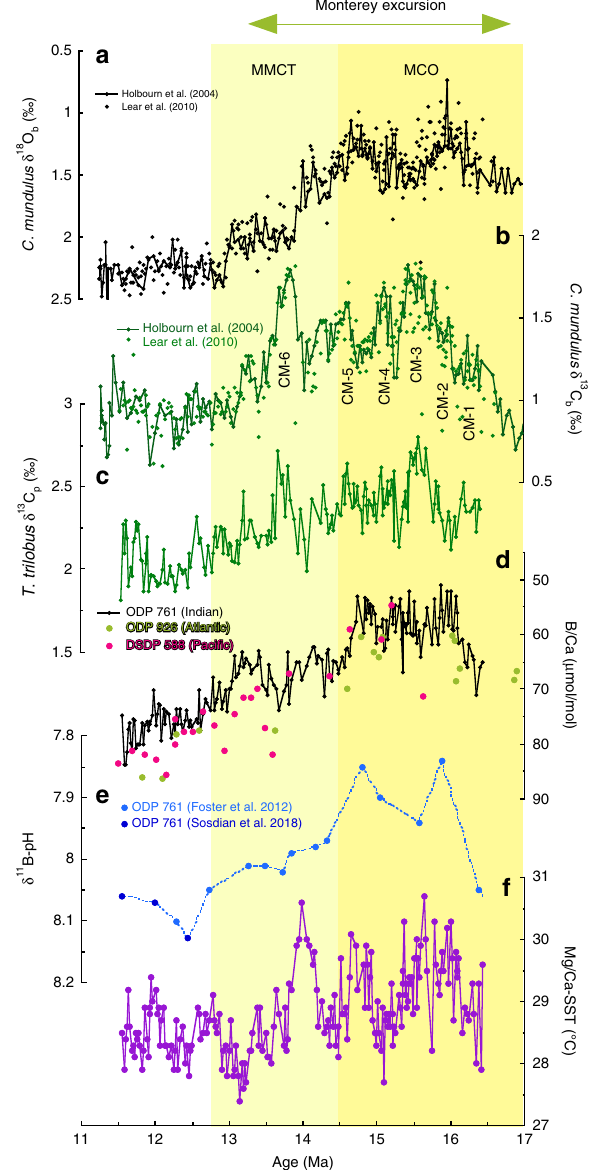
Fig. 1 Isotopic and trace metal records across the middle Miocene.